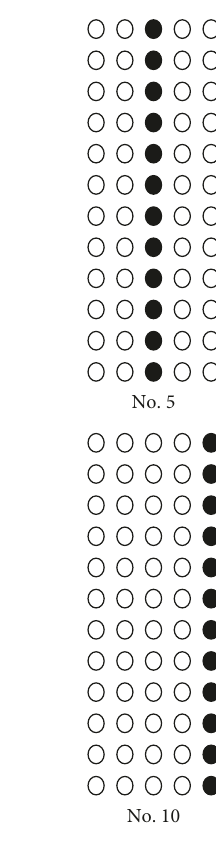
MediationOnline Short-term online G-DA: Online G-DA class:Concurrent and Interactionist